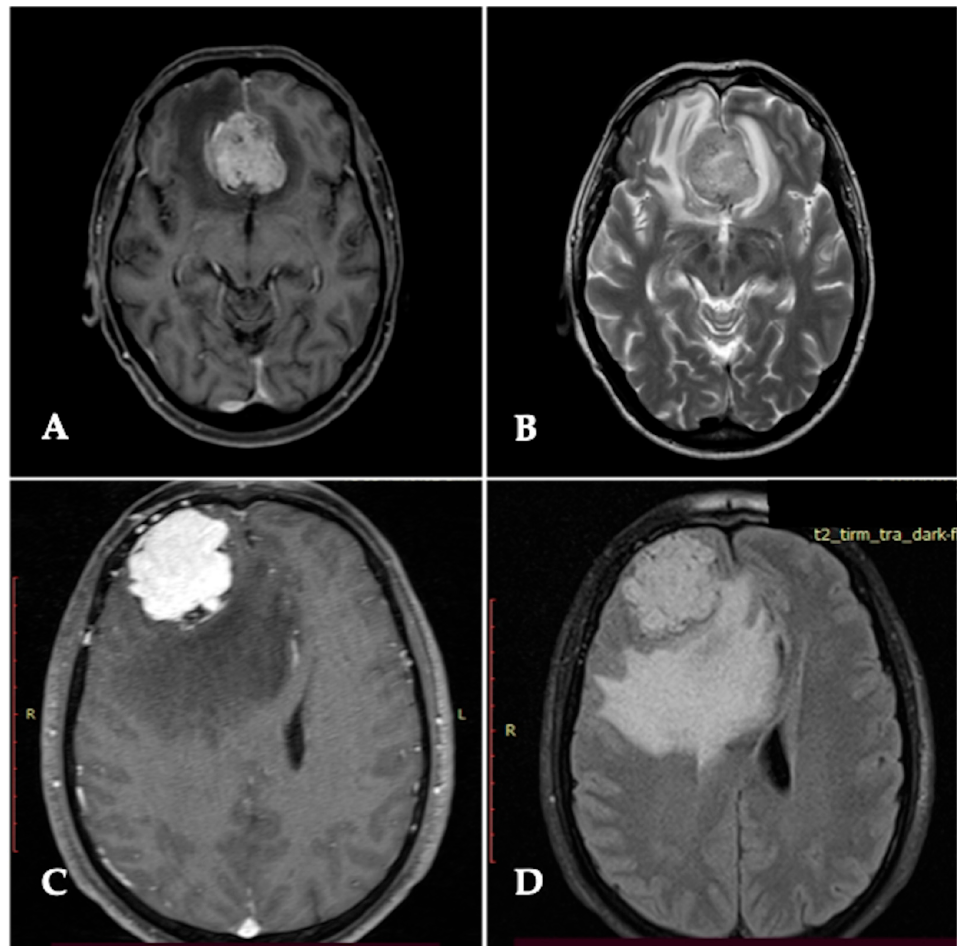
Figure 4. T2-weighted and FLAIR MRI demonstrating the degree of peritumoral edema between a skull-base meningioma ( A , B ) and a convexity meningioma ( C , D ), respectively. Some authors correlate it to tumor grade, consistent with lower grade meningioma in skull-base located meningioma and higher grade in convexity located meningioma.